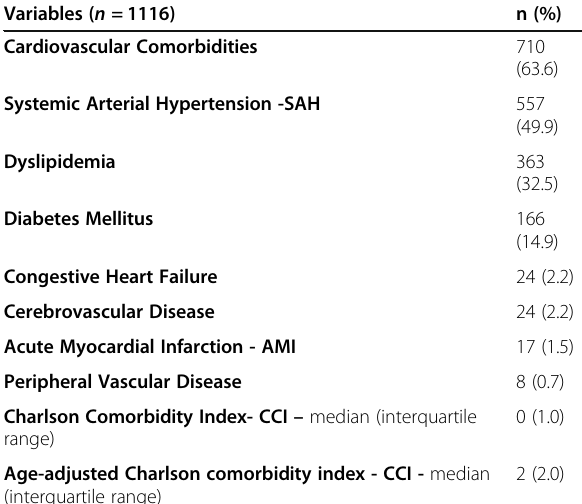
Table 2 Cardiovascular comorbidities of rheumatoid arthritis patients of the REAL study